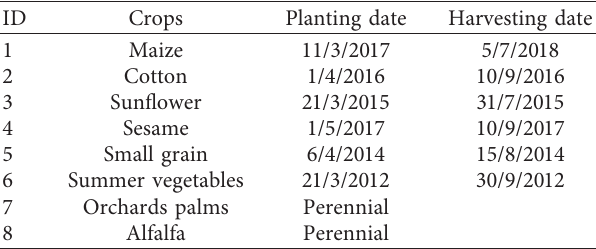
Table 4: Dates of planting and harvesting for considered crops in Al-Hussainiyah irrigation project [31].